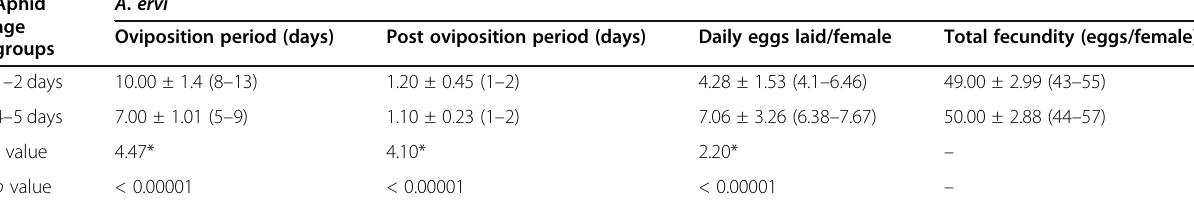
Figures in parentheses represent the range All values are mean of 10 observations *Significant at p < 0.05 and df =